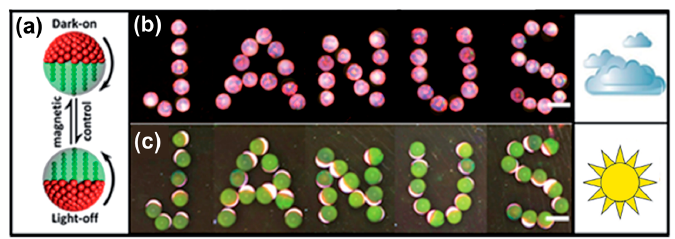
Figure 16. Magnetic Janus supraparticles ( a ) switched using the different hemispheres at different light intensities: upwards directed ( b ) PS hemisphere at low light intensity or ( c ) Fe 3 O 4 -TMPTA hemisphere under strong light intensity; scale bars are 500 µm. Adapted with permission from [117] (p. 9435). Copyright 2014 Royal Society of Chemistry.